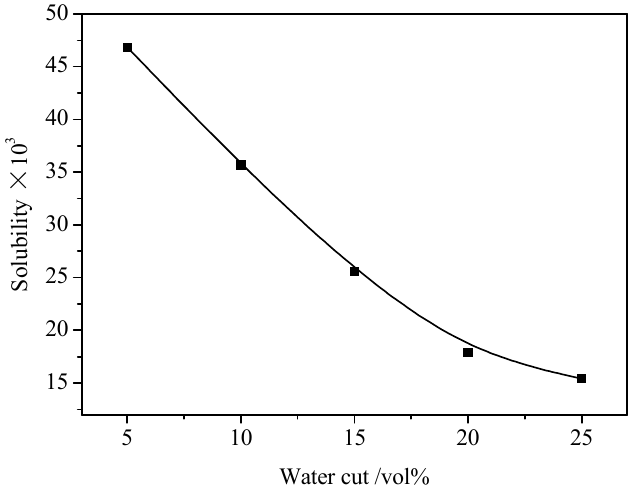
Figure 5. Variation of natural gas solubility in (diesel oil + water + 3 wt% anti-agglomerant) emulsion with water cuts when at 1.2